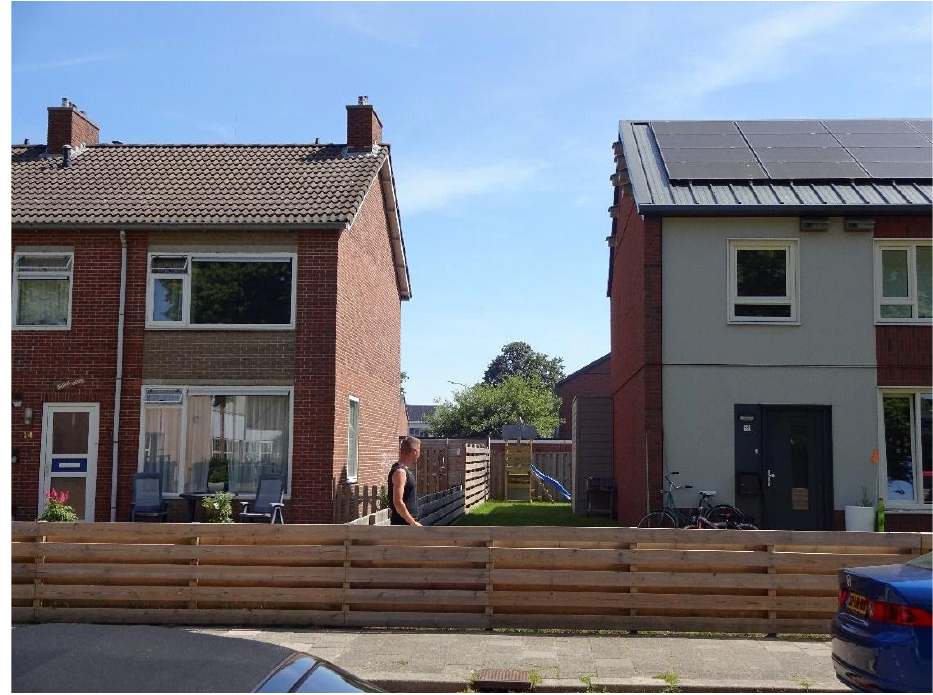
Figure 2. Stadskanaal. On the right, we can see a resident is in his garden, satisfied with his new house. On the left and in other houses of the district the renovation project did not take place because the residents were opposed to it.